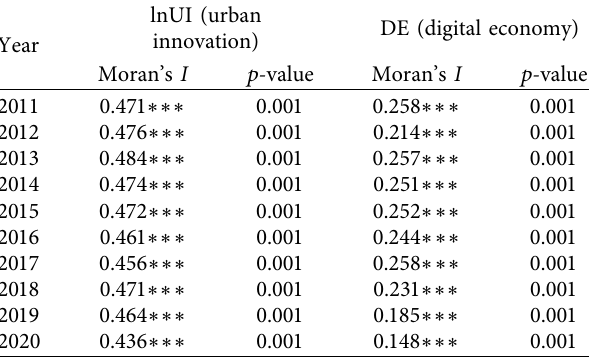
Table 2: Spatial autocorrelation test results of urban innovation and digital economy.